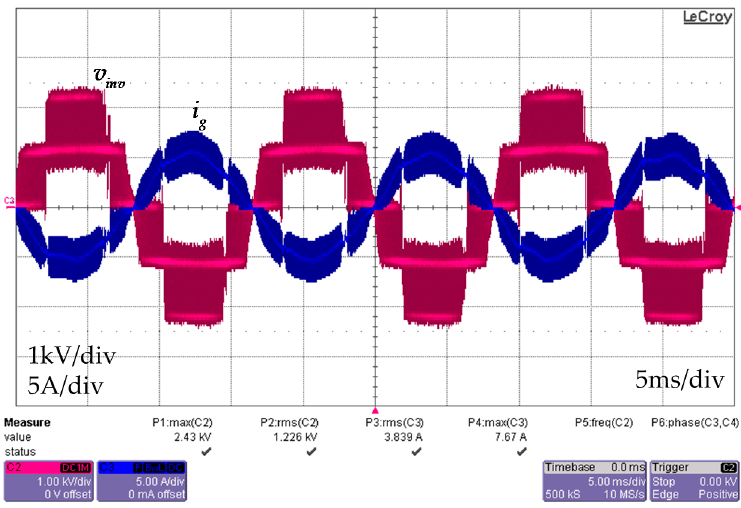
Figure 18. The switching voltage and the input current of the single AFE converter.